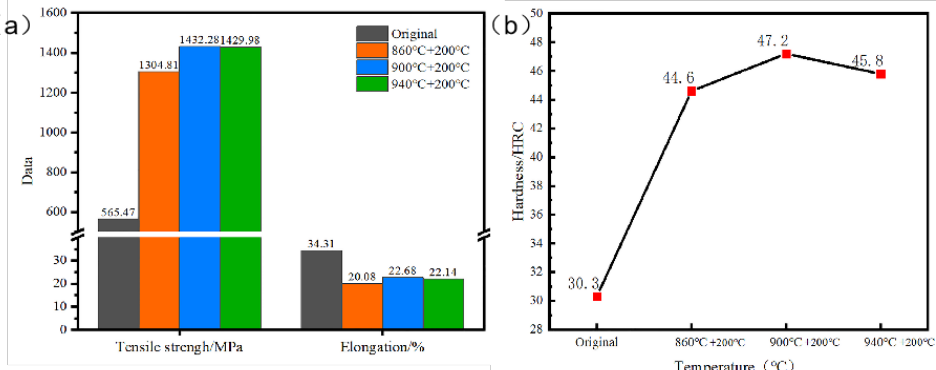
Figure 6. Mechanical properties of clad plates tempered at different austenitization temperatures + 200 °C tempering: ( a )the data of tensile strength and elongation of clad plate; ( b )the hardness of clad + 200 ◦ C tempering: ( a ) the data of tensile strength and elongation of clad plate; ( b ) the hardness of plates. clad